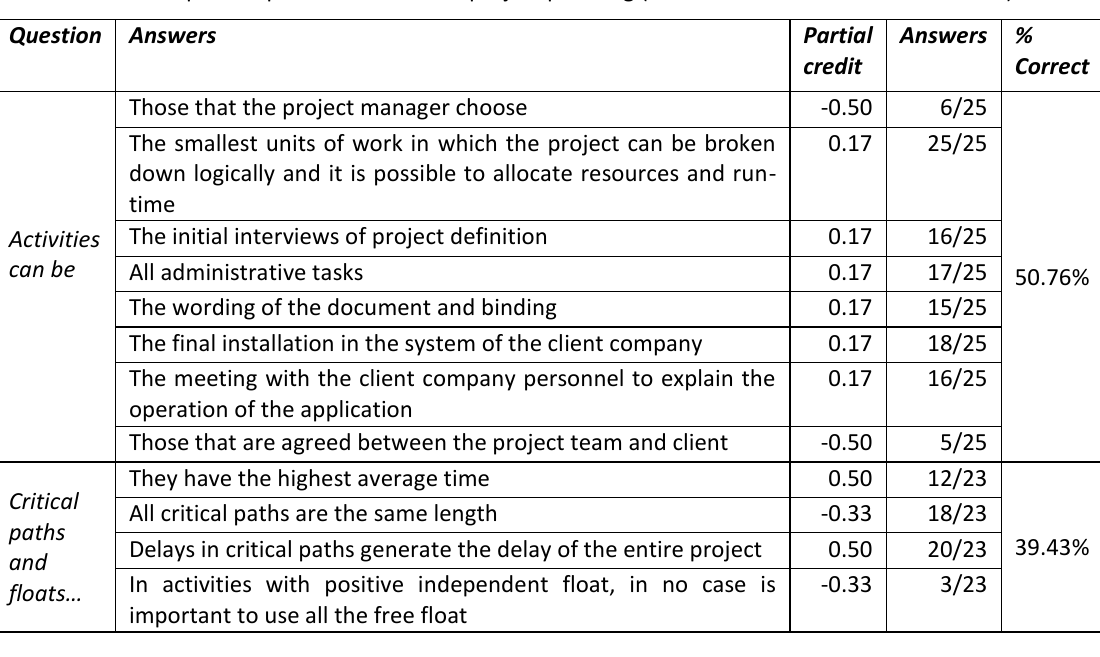
Table 1. Some of the questions used in quizzes and statistical data provided by